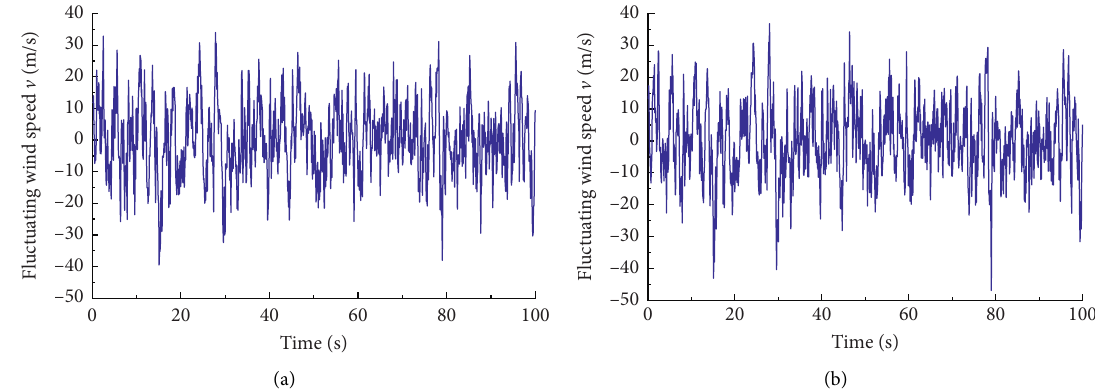
Figure 6: Time-history curve of fluctuating wind speed of plastic greenhouse. (a) Node 4. (b) Node 10.